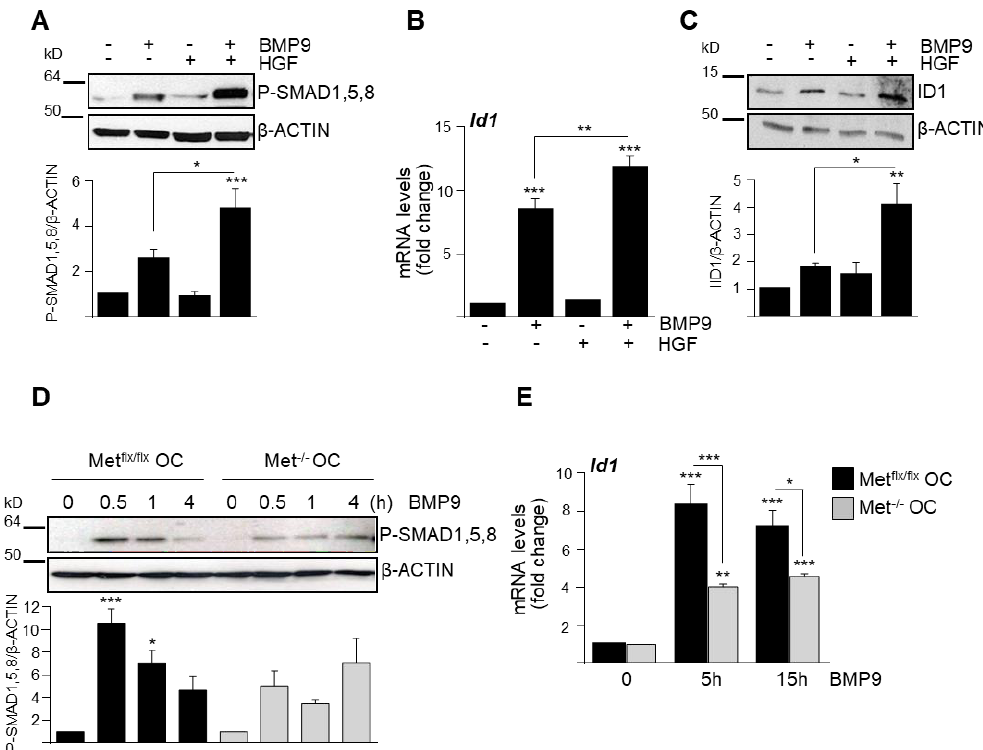
Figure 2. HGF/Met signaling potentiates BMP9-mediated small mothers against decapentaplegic (SMAD) activation in oval cells. ( A ) Western blot analysis of P-SMAD1, -5, -8 in Met flx/flx oval cells treated for 30 min with BMP9 (2 ng/mL) ± HGF (40 ng/mL). One representative experiment is shown (upper panel). Optical density values are mean ± SEM of 8 experiments (bottom panel). ( B , C ) HGF potentiates BMP9-induced increase in ID1. ( B ) Id1 levels analyzed by RT–qPCR in Met flx/flx oval cells treated for 15 h with BMP9 (2 ng/mL) ± HGF (40 ng/mL). Data are mean ± SEM of 4 experiments. ( C ) Met flx/flx oval cells were treated as in ( A ) and ID1 levels were analyzed by Western blot. A representative experiment of 3 is shown (upper panel). Optical density values are mean ± SEM of 3 experiments (bottom panel). D , E . Lack of c-Met catalytic activity decreases SMAD activation and SMAD target gene Id1. Western blot analysis of P-SMAD1, -5, -8 levels in Met flx/flx and Met −/− oval cells treated for different periods of time with BMP9 (2 ng/mL). A representative experiment is shown (upper panel). Optical density values are mean ± SEM of 4 experiments (bottom panel) . E . Id1 levels analyzed by RT–qPCR in Met flx/flx and Met −/− oval cells treated with BMP9 (2 ng/mL) for 15 h. Data are mean ± SEM of 3 experiments. Data were compared with the untreated group or as indicated, * p < 0.05, ** p < 0.01, *** p < 0.001.